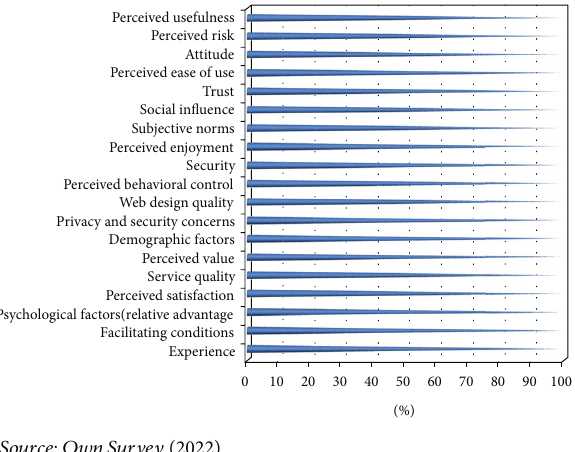
Figure 10: The most in fl uential factors of online consumer